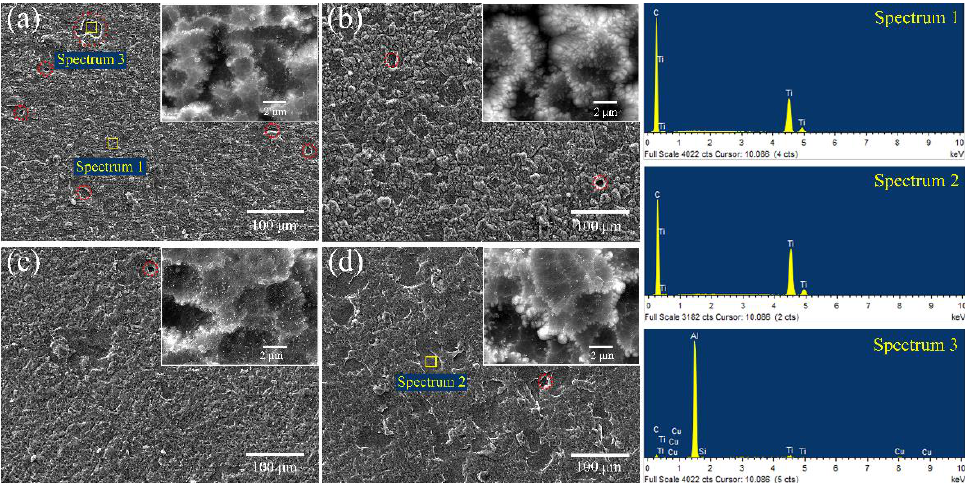
Figure 4. Surface SEM morphology of Ti-DLC coatings with Ti transition layer thickness ( t 0 ): ( a ) 0 µ m, ( b ) 0.5 µ m, ( c ) 1.1 µ m and ( d ) 2.8 µ